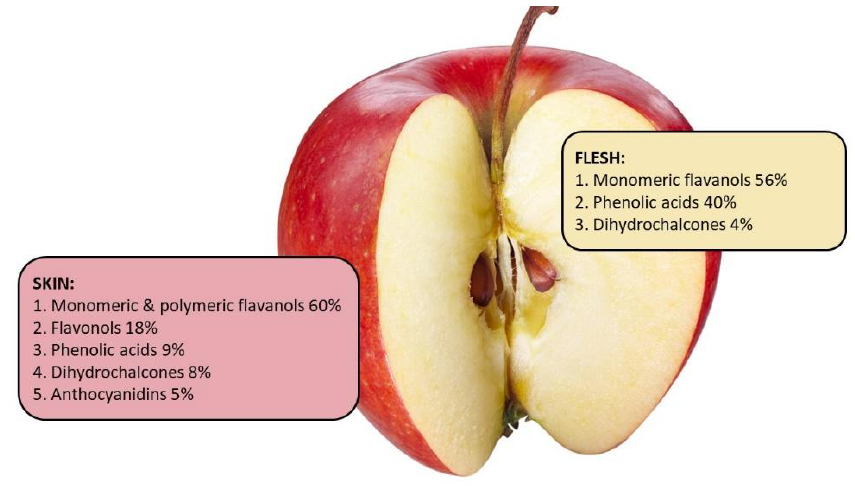
Figure 2. Phenolics distribution pattern in the peel and flesh of an average apple based on the data from Lata, Trampczynska, and Paczesna [71], Tsao et al. [78], Lata [79], and McGhie et al. [62].